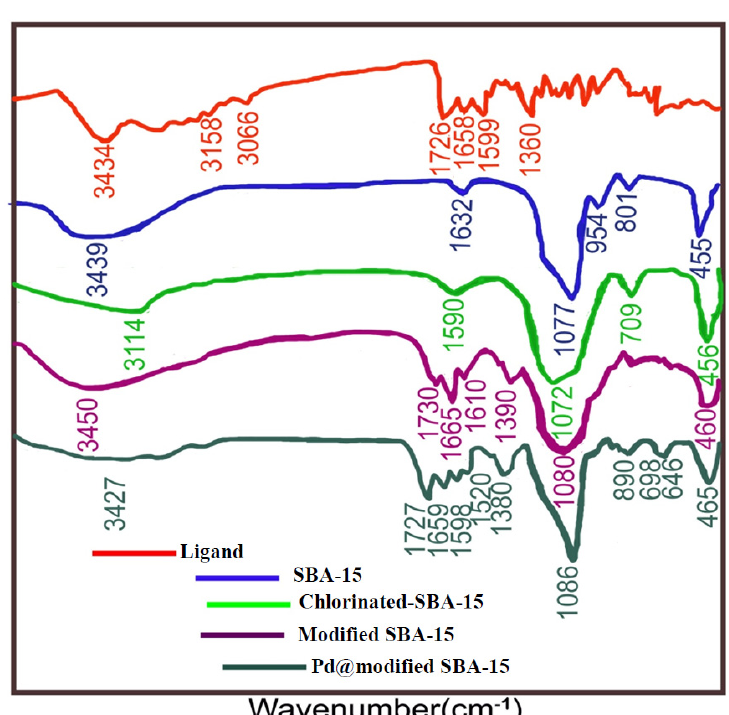
Fig. 5. FT-IR spectra of ligand, SBA-15, chlorinated-SBA-15, modified SBA-15, Pd@modified Figure 5. FT‐IR spectra of ligand, SBA‐15, chlorinated‐SBA‐15, modified SBA‐15, Pd@modified SBA‐15